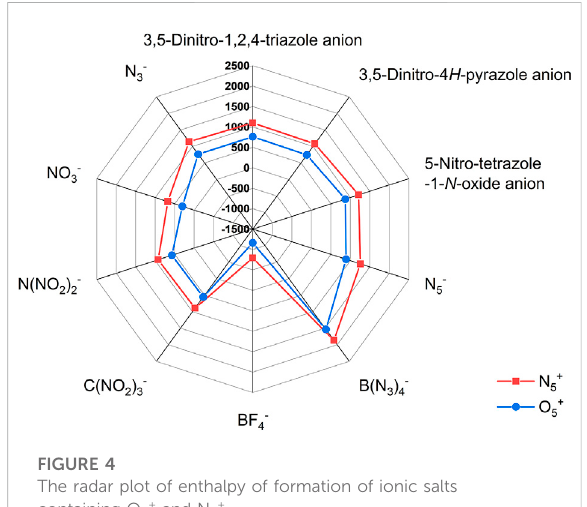
FIGURE 4 The radar plot of enthalpy of formation of ionic salts containing O 2 + and N 5 +